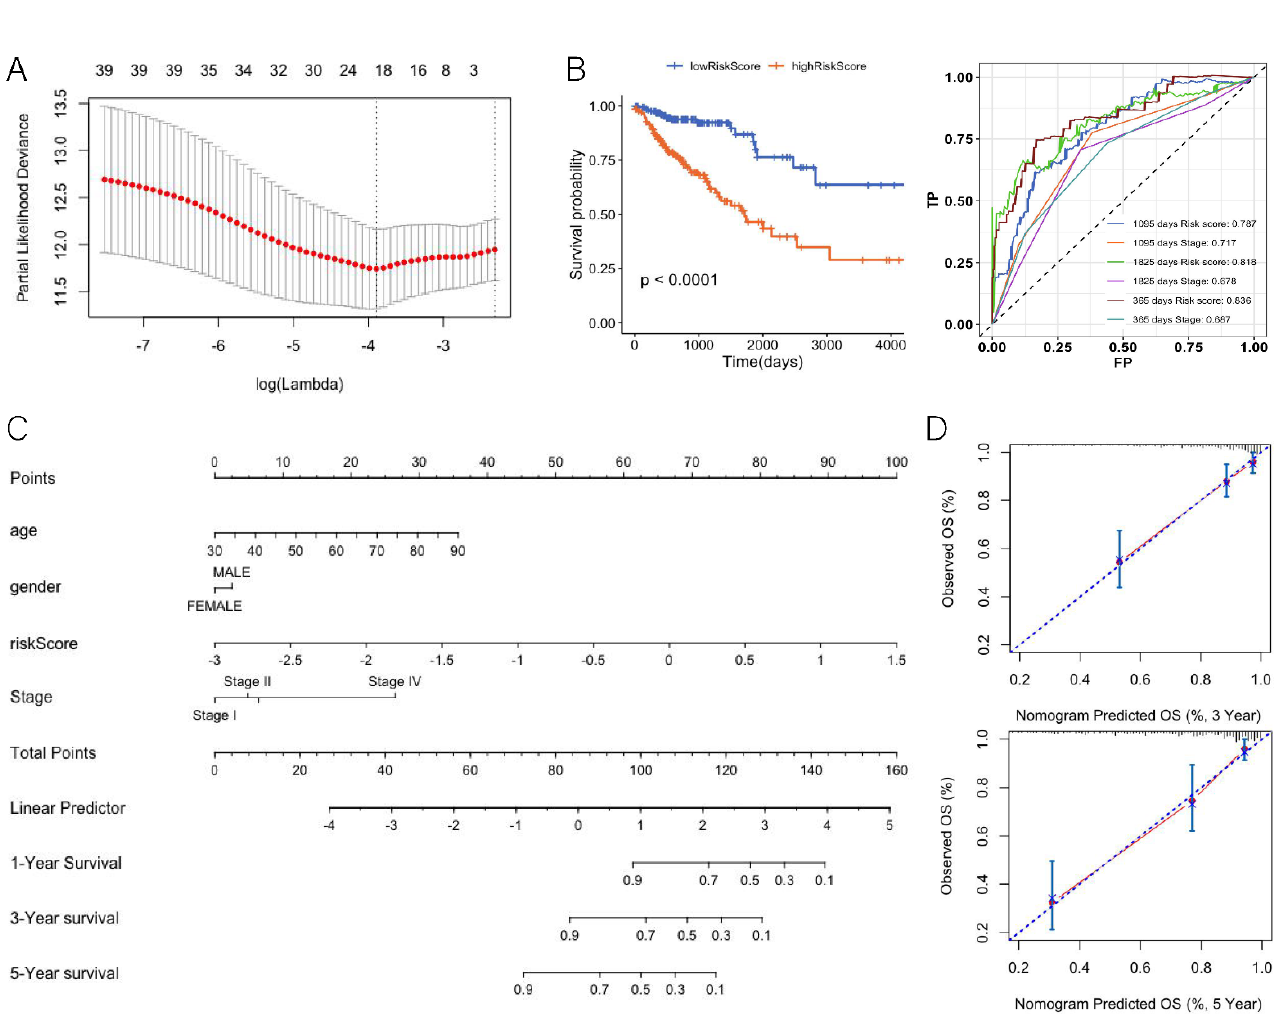
Figure 5. Differentially expressed genes of the TMB high and low groups related to prognosis. ( A ) LASSO cox regression feature-selection results. ( B ) Risk score prognostic curve (left) and risk score ROC curve (right). ( C ) Nomogram for predicting the 3- and 5-year OS. ( D ) Calibration plot for nomogram-predicted and observed 3- and 5- year survival rates.